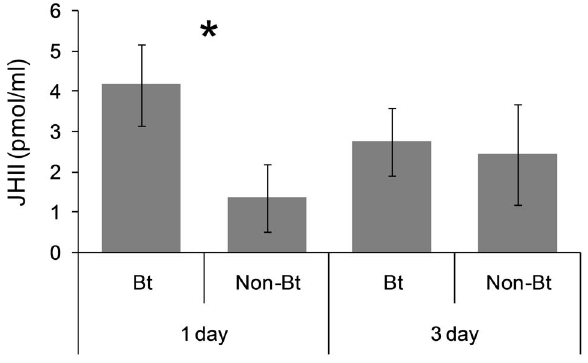
Figure 3. Effect of Bt toxin in the diet on the concentration of JHII in the larval hemolymph of Helicoverpaarmigera . Larvae were fed on the non-Bt or Bt leaves for one (L 6 d1) or three (L 6 d3) days. An asterisk above the columns indicates differences between treatments, and bars indicate SE.